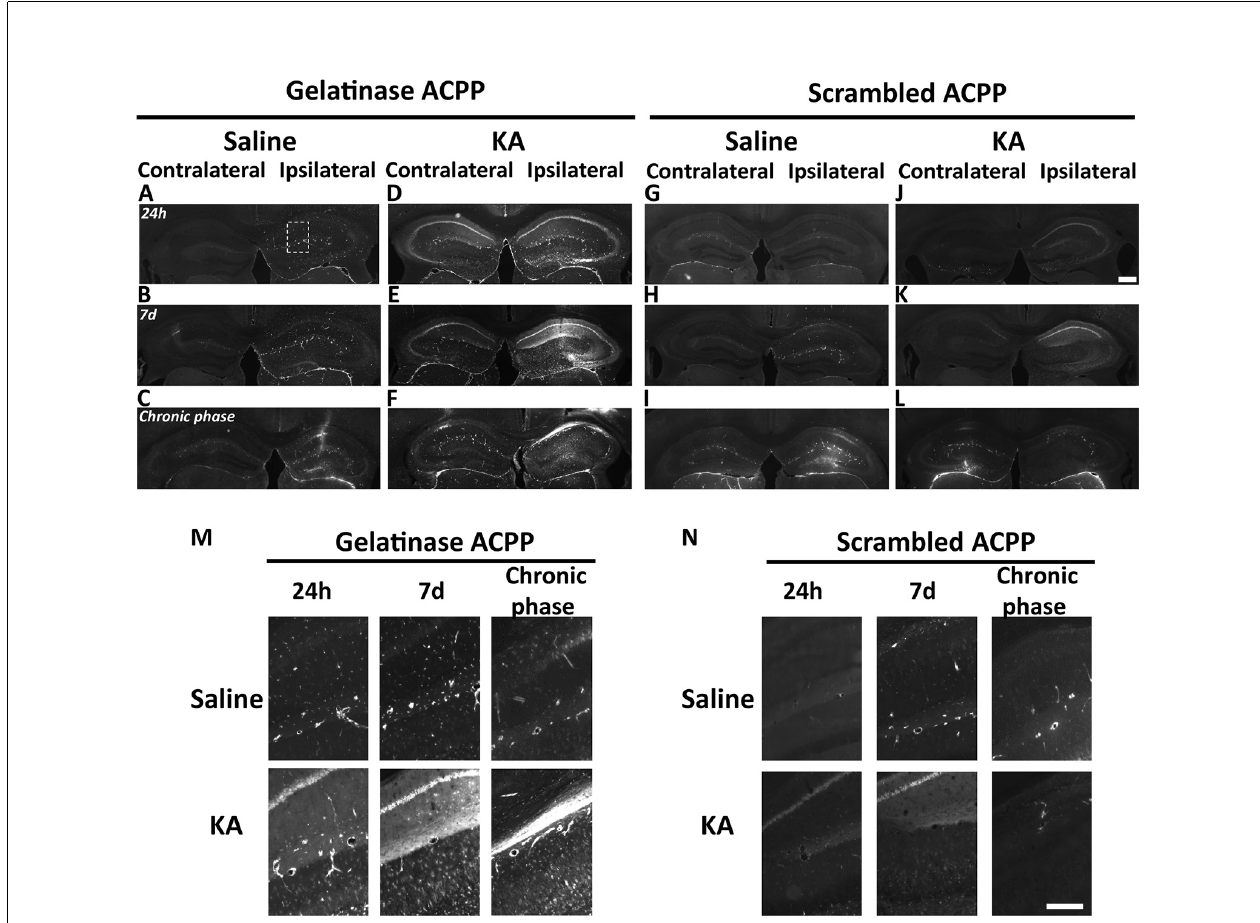
FIGURE 4 | Detection of in vivo gelatinase activity by cleavage of ACPPs in the epileptogenic mouse brain. (A–L) TAMRA ACPP fluorescence in mice brains injected with KA (D–F,J–L) or saline solution (A–C,G-I) in the right hippocampus, and gelatinase-ACPP (A–F) or scrambled-ACPP (G–L) in ipsi- and contralateral sites. Mice were sacrificed 24 h, 7 days or 8 weeks after KA injection ( n = 3 independent experiments, two or three animals injected per condition for each experiment). (M,N) Enlarged image of the outlined area in panel (A) showing TAMRA Gelatinase- (M) or Scrambled- (N) ACPP fluorescence in the ipsilateral hippocampus. Scale bars: (J) , 500 µ m, (N) 250 µ